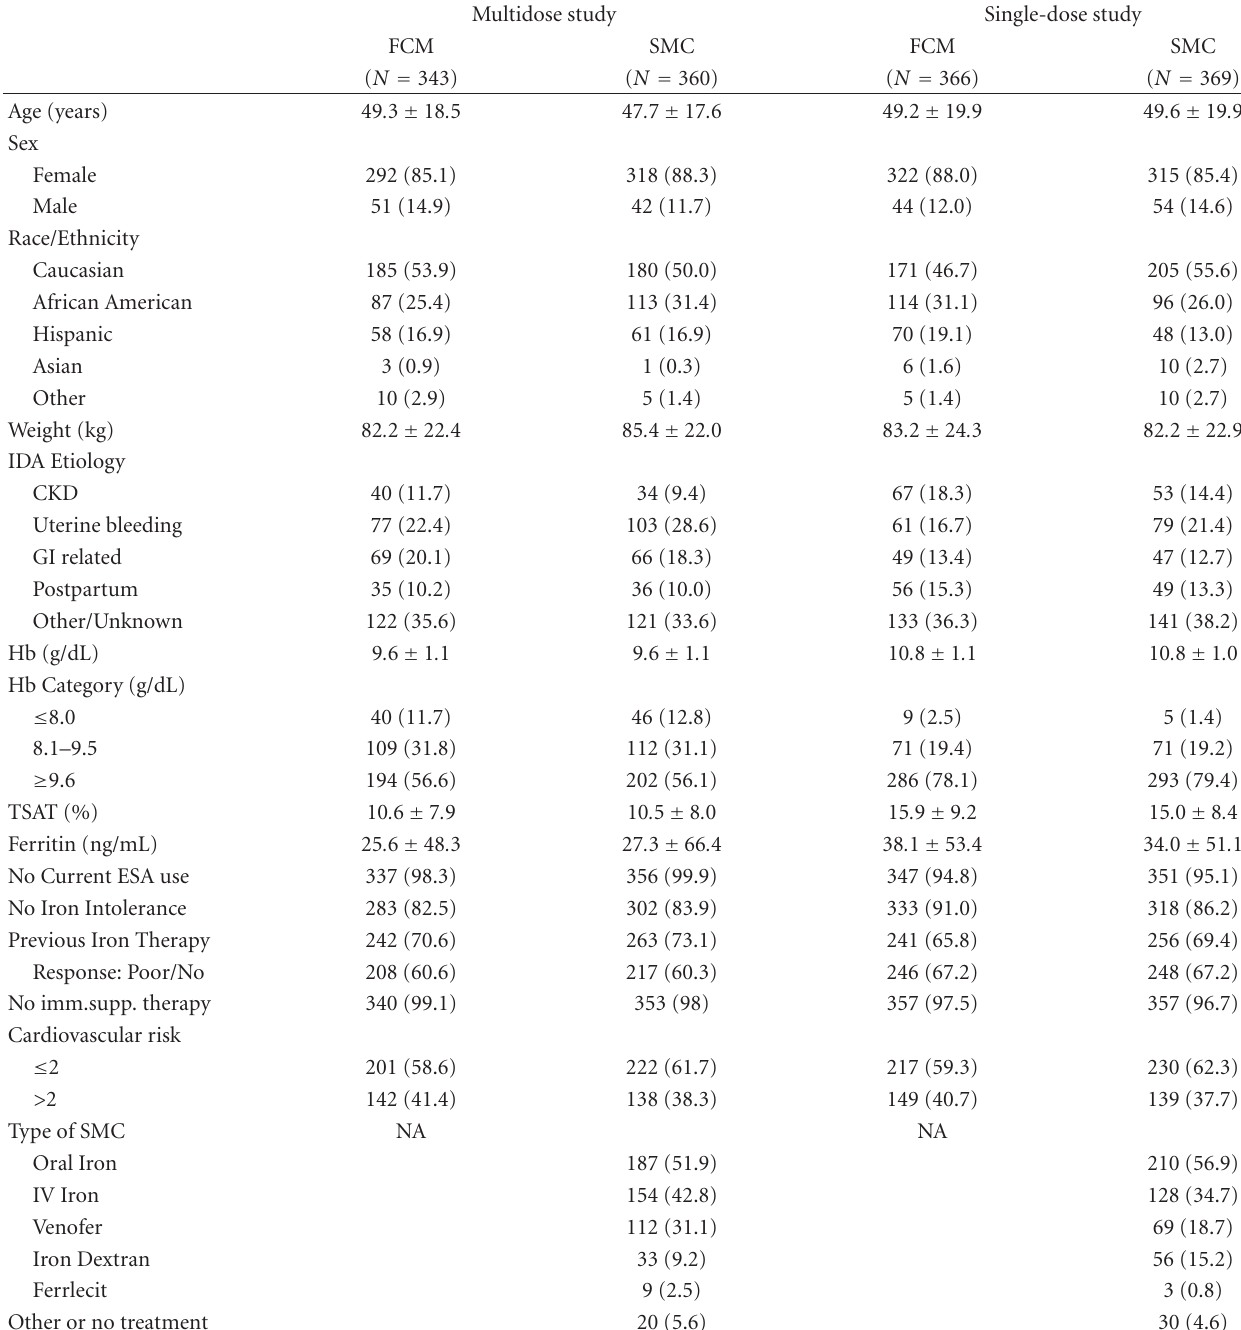
Table 1: Demographics and baseline characteristics of subjects (safety